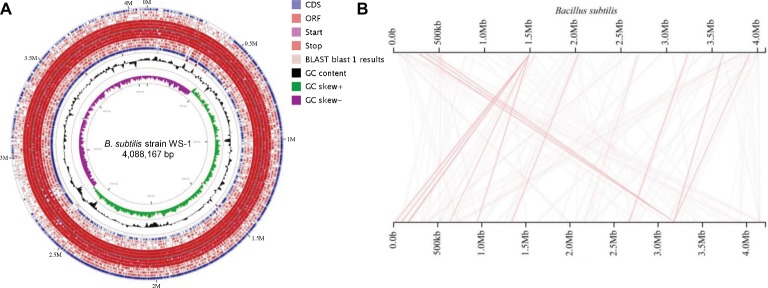
Genome visualization and genomic synteny of the B. subtilis strain WS-1. (A) Genome visualization of B. subtilis strain WS-1. The genome of B. subtilis strain WS-1 was sequenced and analyzed using the PacBio platform. (B) Genomic synteny of B. subtilis strain WS-1 was analyzed based on the alignment results with B. subtilis.